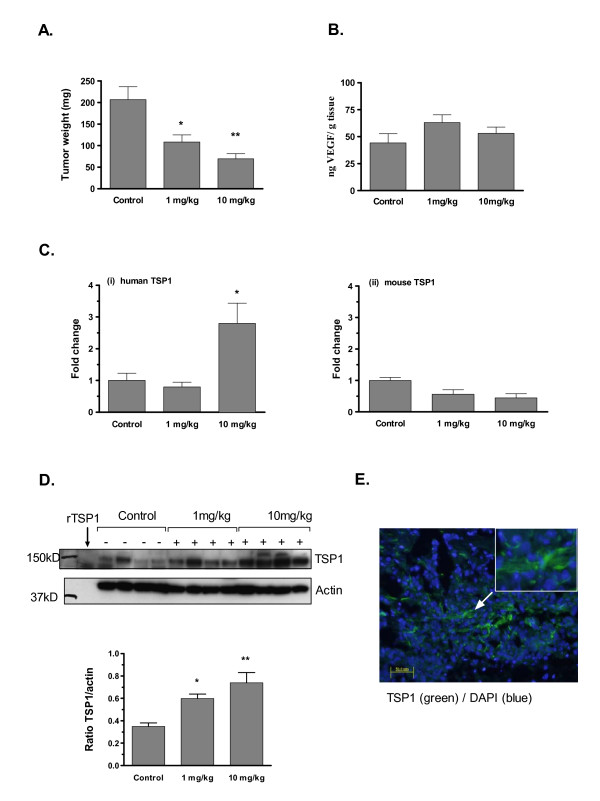
Anti-tumor effect and up-regulation of tumor associated human TSP1 mRNA levels in tasquinimod treated LNCaP tumors. Anti-tumor effect in nude mice carrying subcutaneous LNCaP tumors treated with tasquinimod (10 mg/kg/day) for three weeks. The treatment started 7 days after inoculation, and expressed data represent the mean tumor weight ± SD (n = 5; p = 0.0076, ANOVA). (B) VEGF levels were measured in processed tumor tissue by ELISA. (C) Up-regulation, monitored with real-time qRT-PCR, of tumor associated human TSP1 mRNA levels ((i); p = 0.0216, ANOVA) in LNCaP tumors. To distinguish between mRNA from human tumor cells and infiltrating mouse cells, TSP1 mRNA was analyzed using primers specific for human (i) or mouse (ii) sequences with the same probe set (Table 2). (D) Elevated protein levels of tumor-produced human TSP1 (rabbit polyclonal Ab8). Each lane represents a tumor sample from an individual animal. Calculated ratios between the major band of intact TSP1 (approximately at 150-160 kD) and actin in each lane show a significant (p = 0.0004, ANOVA) up-regulation of TSP1 tumor levels in exposed animals ((+); n = 4) compared to untreated controls (-). (*) p ≤ 0.05 and (**) p ≤ 0.01 (Bonferroni's multiple comparison test). (E) TSP1 expression (green) analyzed by IHC microscopy in LNCaP tumor tissue exposed in vivo to tasquinimod at 10 mg/kg/day (bar = 50 μm). TSP1 was mainly localized in the extra cellular matrix (inset). Blue shows DAPI staining.